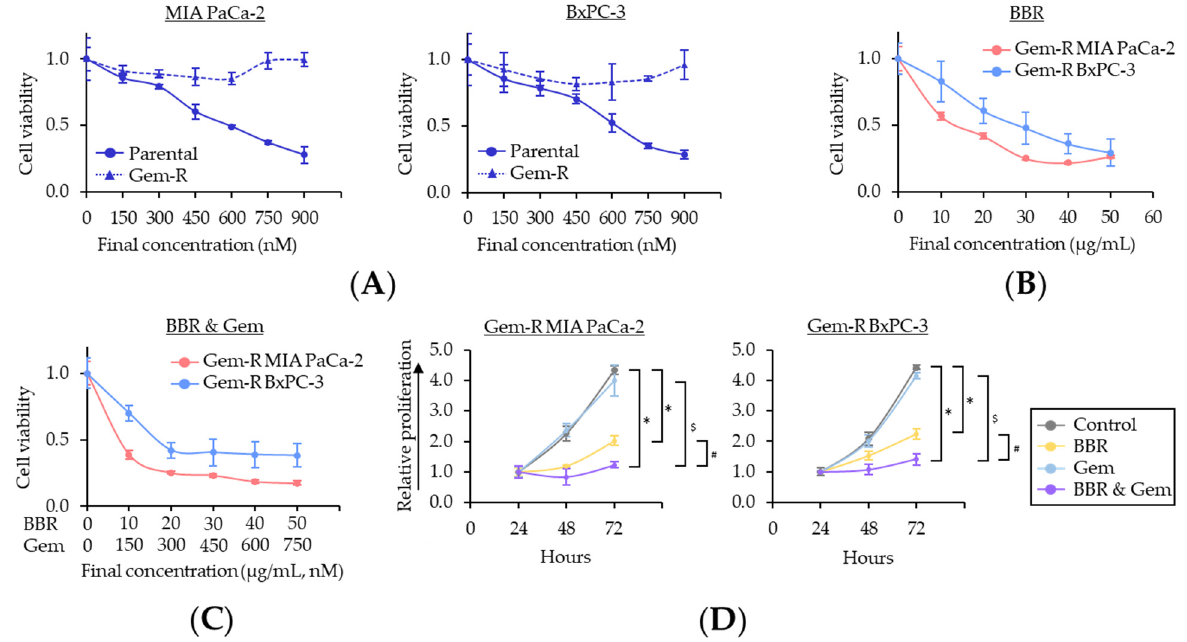
Figure 1. Berberine enhances the chemosensitivity to Gemcitabine-resistant PDAC cells in inhibiting cell proliferation. ( A ) Drug dose–response curves comparing cell viability following treatment with Gem in parental and Gem-R PDAC cells. Error bars are the mean ± SD; ( B ) Drug dose–response curves comparing cell viability following treatment with BBR in Gem-R PDAC cells. Error bars are the mean ± SD; ( C ) Drug dose–response curves comparing cell viability following treatment with combination of BBR and Gem in Gem-R PDAC cells. Error bars are the mean ± SD; ( D ) Cell proliferation assays in Gem-R PDAC cells with BBR, Gem, and their combination. Total viable cells were measured by CCK-8 assays on the indicated days. Error bars are the mean ± SD (* p < 0.05 vs. control, # p < 0.05 vs. BBR, $ p < 0.05 vs. Gem). Gem-R, Gemcitabine-resistant; PDAC, pancreatic ductal adenocarcinoma; BBR, Berberine; Gem, Gemcitabine; CCK-8, Cell Counting Kit-8; SD, standard